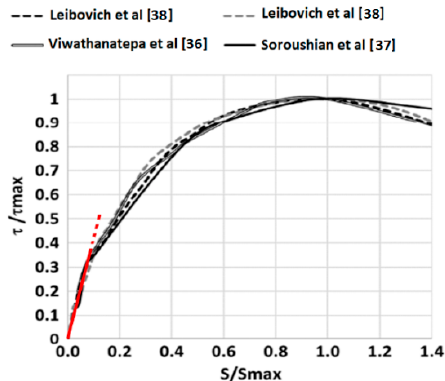
Figure 4. The linear bond–slip relationship at limited slips .